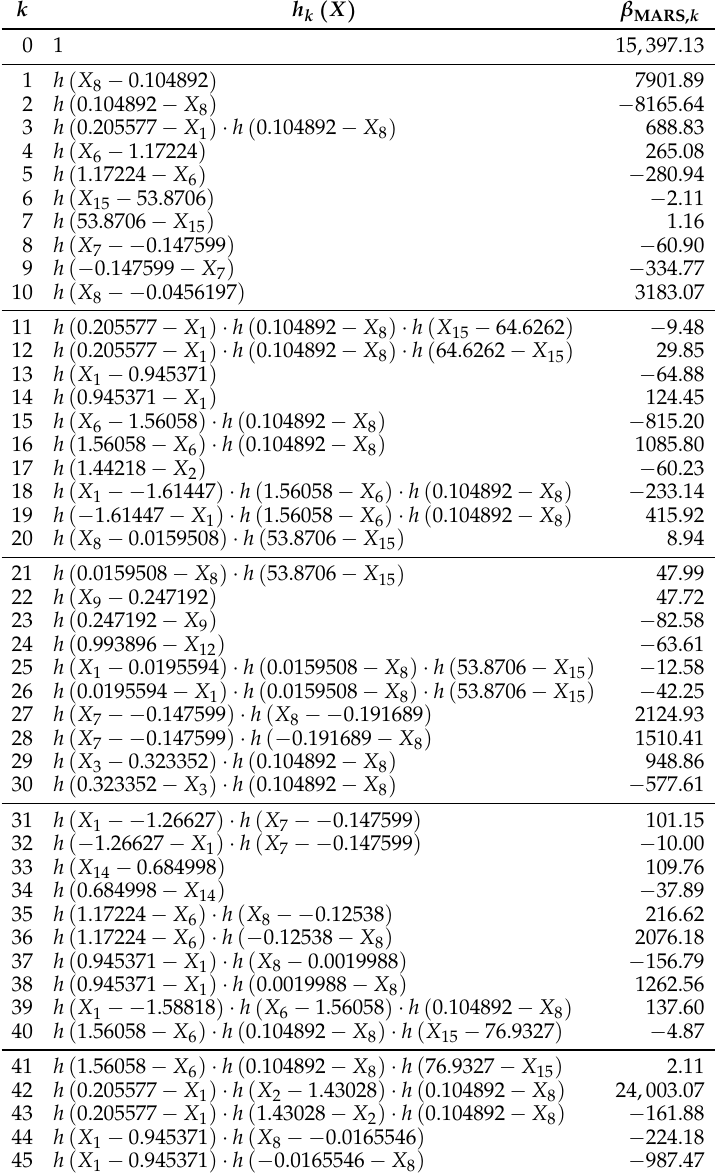
Table A32. Best MARS model of BEL derived in a two-step approach with the final